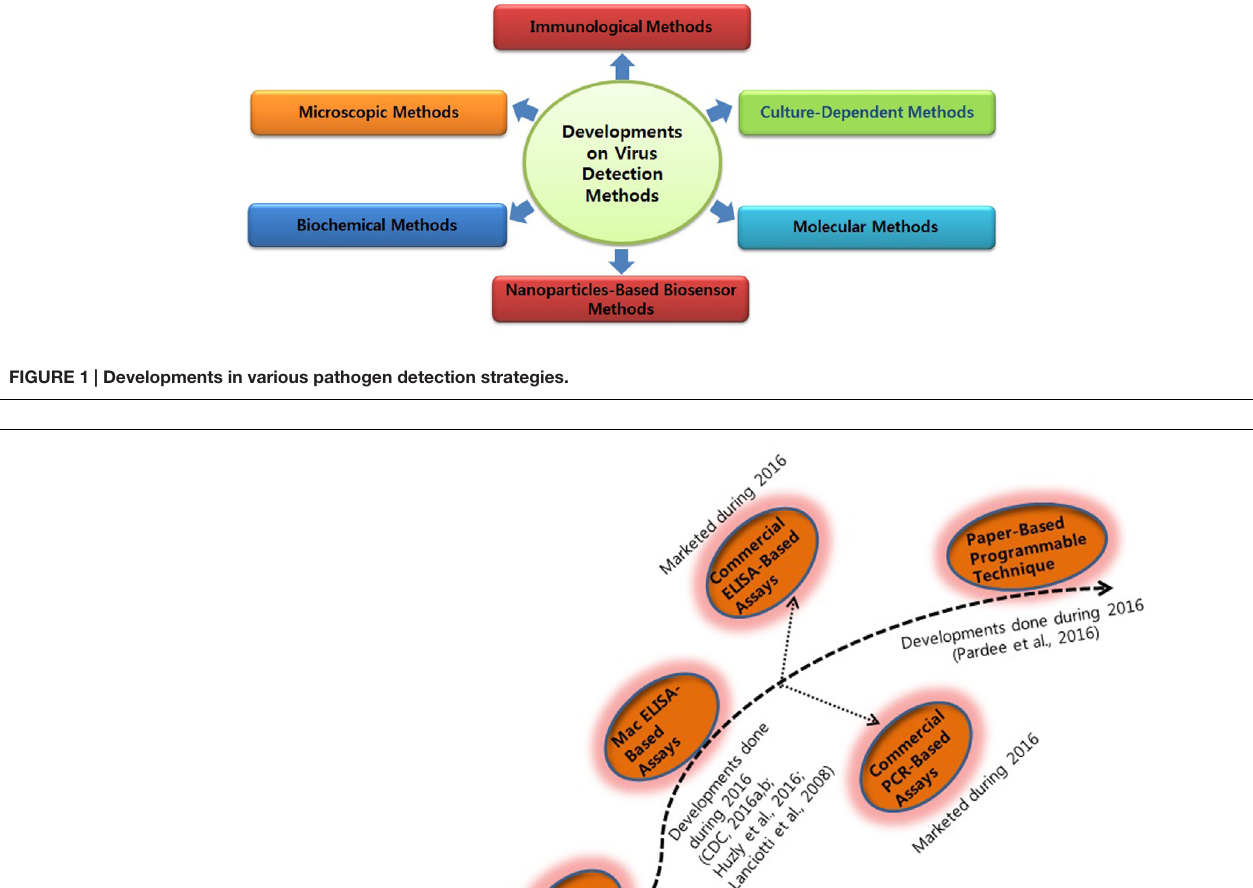
Frontiers in Microbiology |